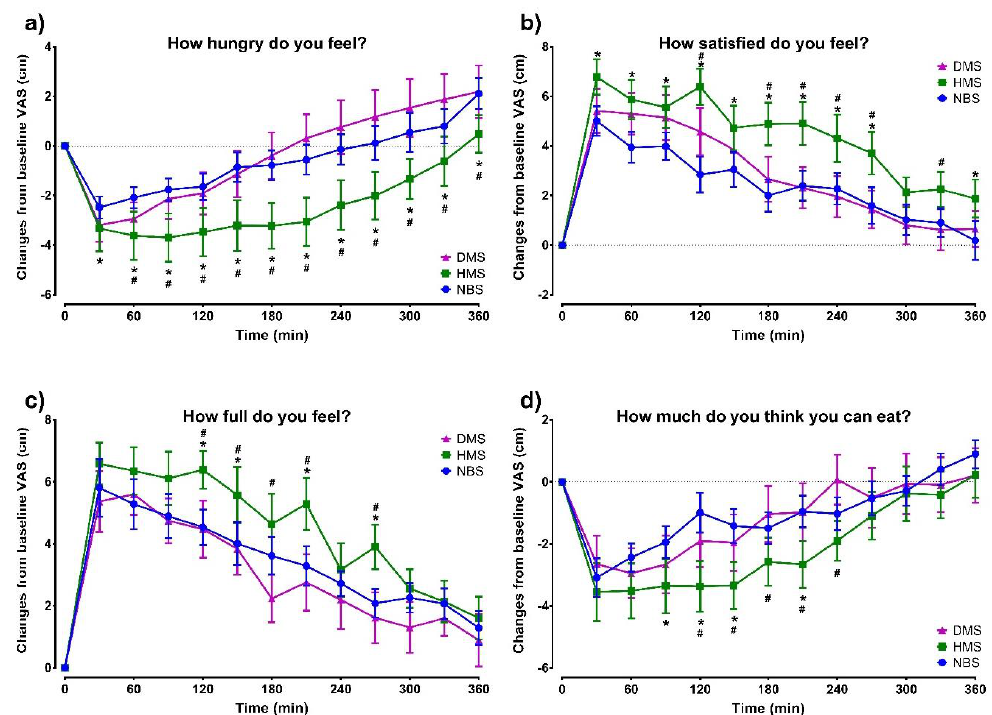
Figure 4. Effects of NBS on the subjective estimation of appetite using the visual analogue scale (VAS). (a) Hunger; (b) satiety; (c) fullness; (d) prospective consumption. Data are presented as changes from baseline and are expressed as mean ± SEM ( n = 14). Comparisons are based on two-way ANOVA with the Tukey post-hoc test. * p < 0.05, HMS vs. NBS; # p < 0.05, HMS vs. DMS.